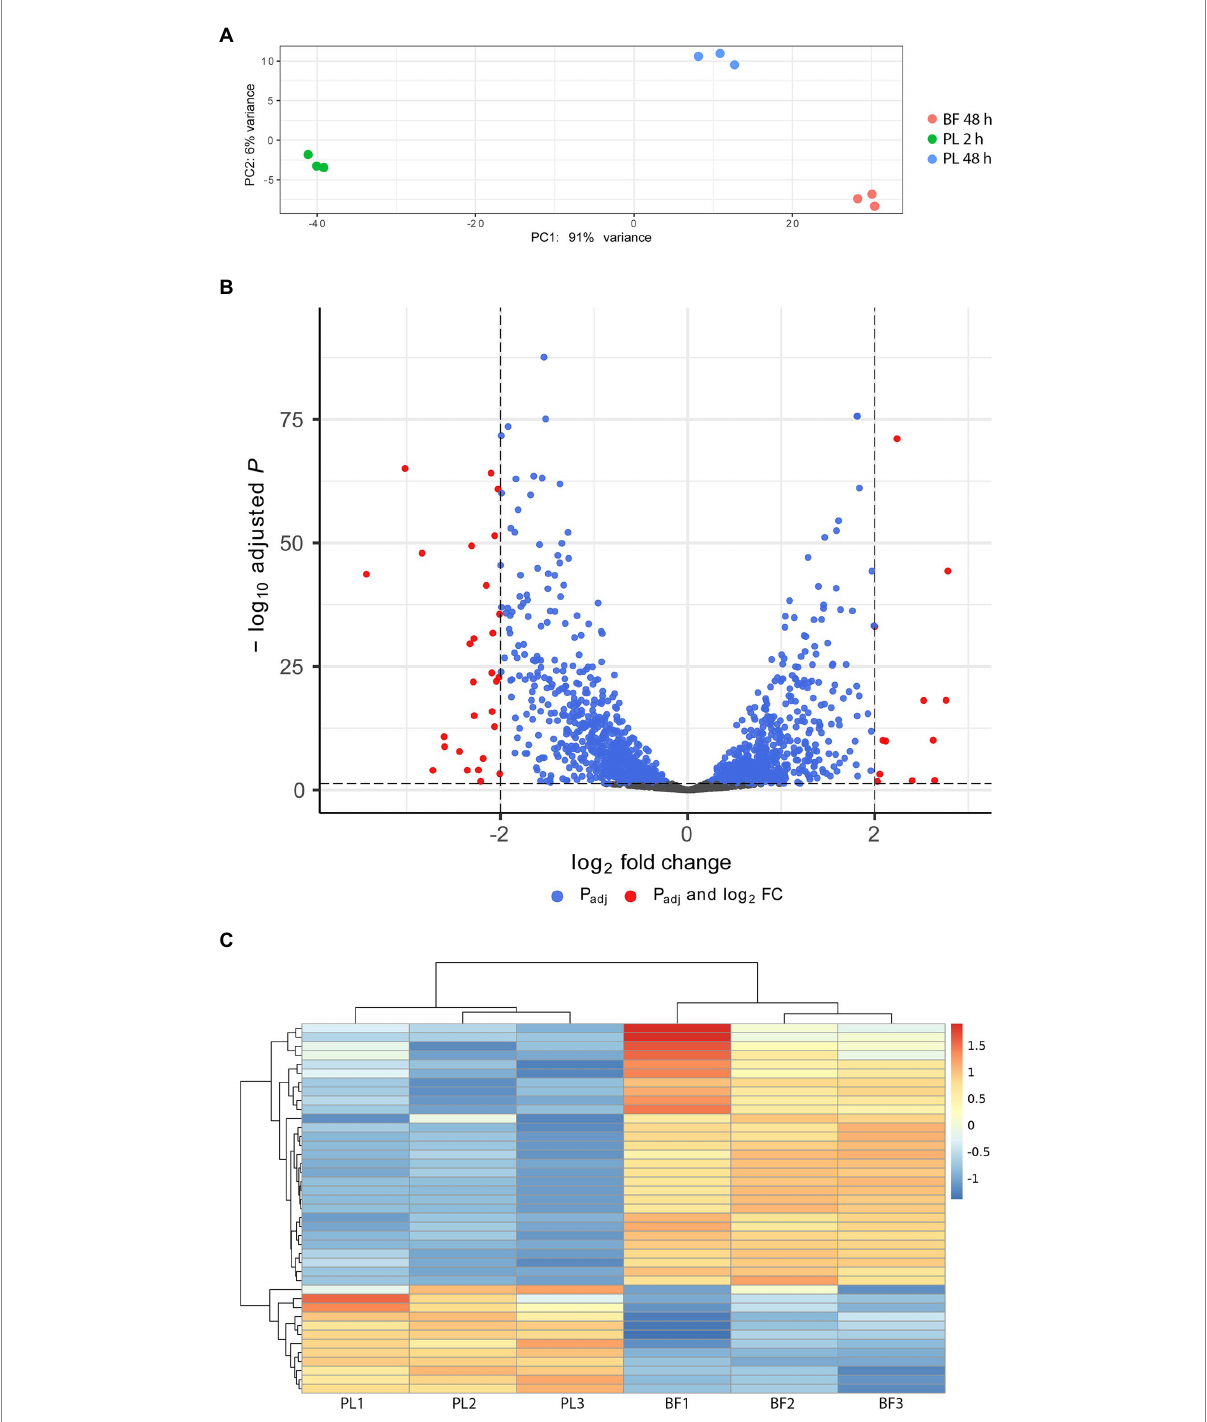
FIGURE 5 Comparative gene expression analysis between biofilm-embedded and planktonic cells of S. saccharolyticus . (A) Principal component analysis (PCA) of the gene expression data of nine cultures, including three applied conditions (biofilm at 48 h (BF 48 h), planktonic cells at 48 h (PL 48 h) and at 2 h (PL 2 h)) in three biological replicates. (B) Volcano plot of differentially expressed genes between biofilm and planktonic cells at 48 h. The plot shows the log2-fold-change values on the X-axis against the adjusted p values ( − log10 scale) on the Y-axis. Red dots represent genes that showed gene expression differences with log2-fold change >2 or < − 2. (C) Heatmap of differentially expressed genes between biofilm (BF) and planktonic (PL) cells at 48 h; shown is the data for all three biological replicates. The corresponding locus tags and gene annotations are listed in Table